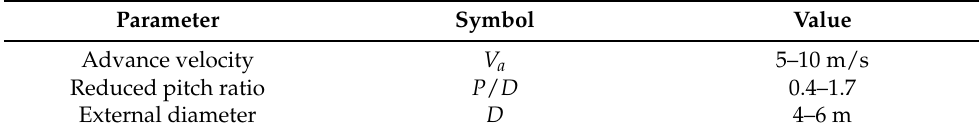
Table 3. Realistic design variable ranges of the